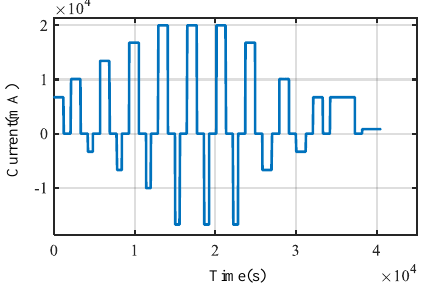
Figure 2. The current used for identification [29].